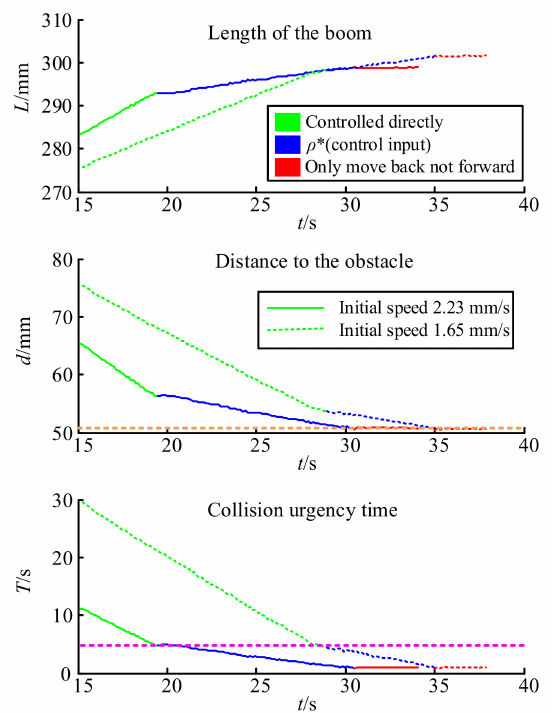
Figure 11. Result of the stretching test.